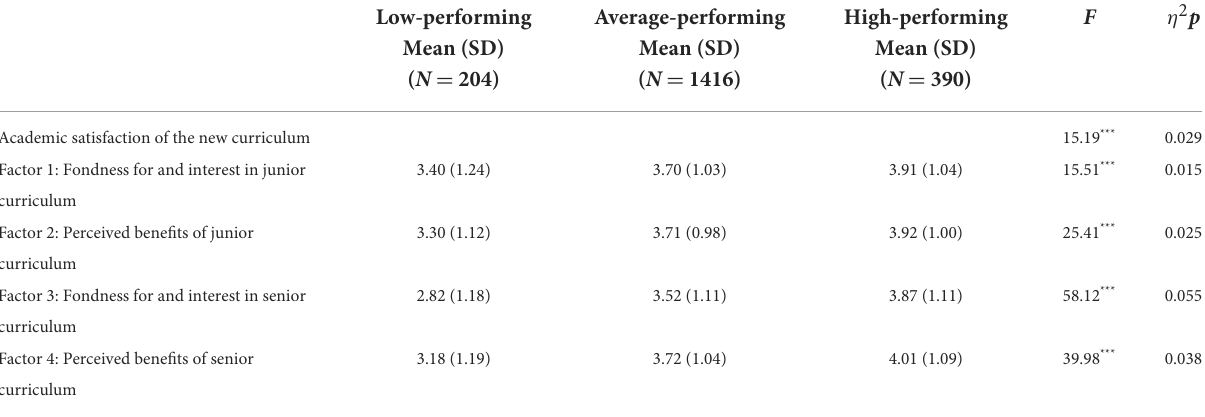
TABLE 8 Results of MANOVA by academic